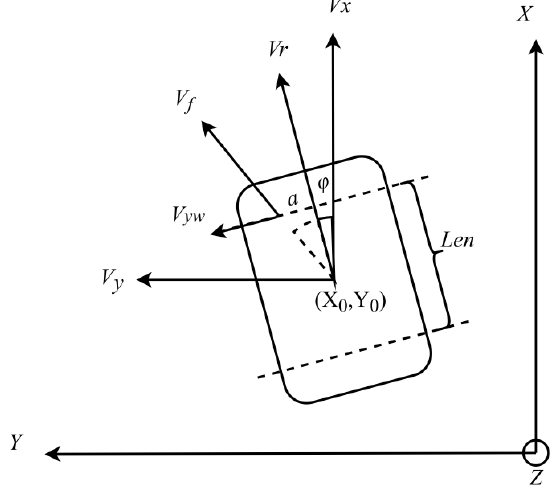
Figure 3. Coordinates of quadruped robot in geodetic coordinate system, where ( X 0 , Y 0 ) is the gravity position of robot; Vx and Vy are the actual running speeds in the geodetic coordinate system; V f is the running speed in the offset direction; Vr and V yw are the velocity components of V f on the longitudinal centerline and transverse centerline of the quadruped robot, respectively; Len is the length of the robot body; and a , ϕ are the rotation angle of the single leg and the overall yaw angle of the robot, respectively.